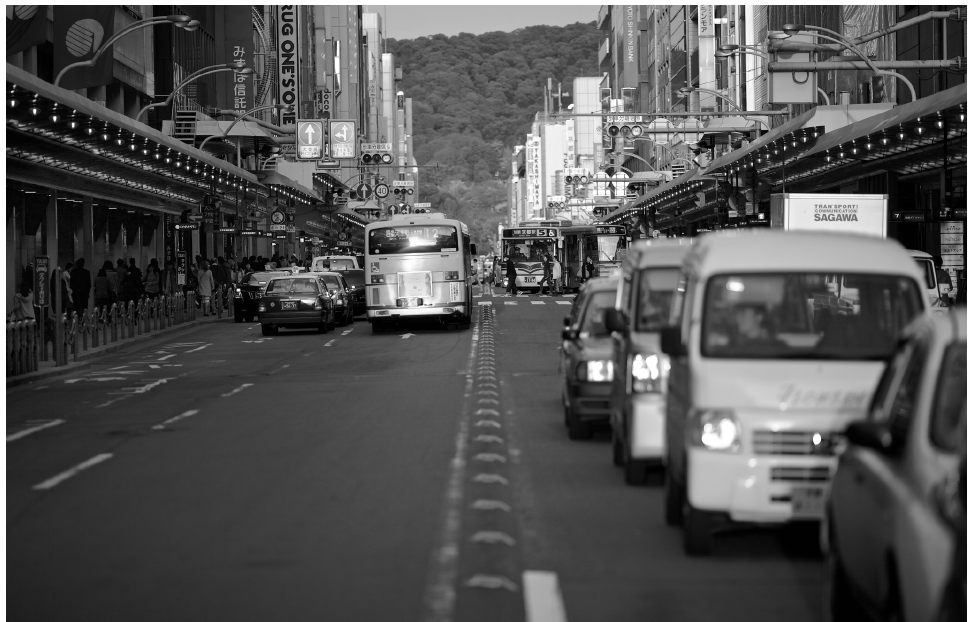
Figure A3. Picture of traffic (8-bit, cropped to 2048 × 1320, and converted to gray) from the Challenge on learned image compression (CLIC) dataset (Available online: http://compression.cc/tasks/,